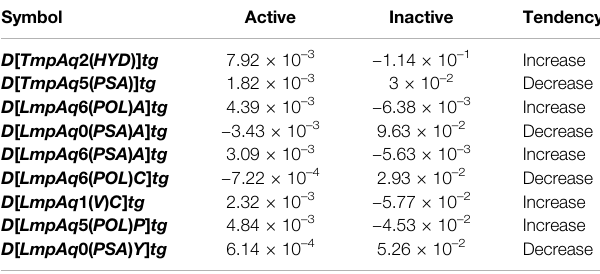
TABLE 3 | Tendencies of variation of the molecular descriptors in the mt-QSAR- MLP model according to the classes-based means ’ approach.